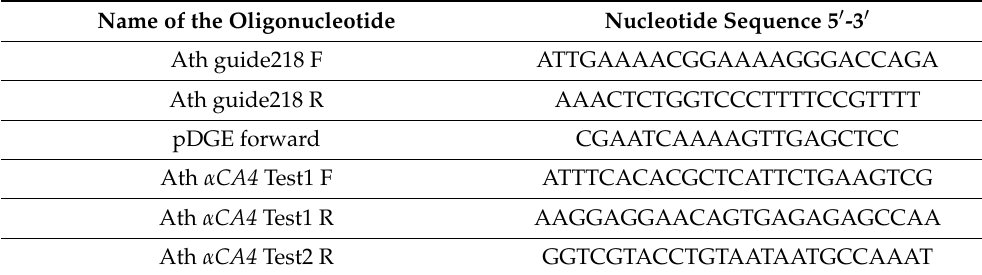
Table 2. Oligonucleotides used for gRNA